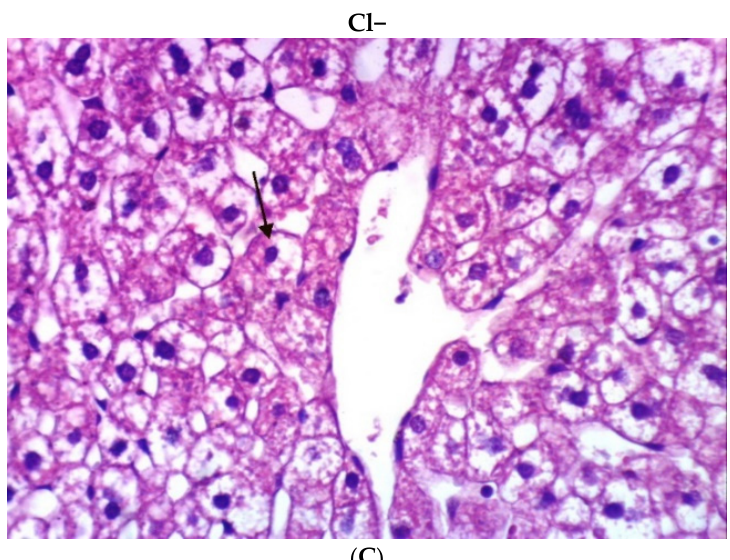
Figure 2. ( A ). Villus morphology and morphometry characteristics of the small intestine in the rabbits receiving yogurt fortified with 1% whey protein concentrate (G1), calcium caseinate (G2) and Spirulina powder (G3) as compared to that of non-supplemented yogurt (positive control: Cl+) or a yogurt-free diet (negative control (Cl − ) (H & E X 100). The groups (G1–G3 and Cl+) received yogurt at a dose of 5 g/kg body weight/day. ( B ). Villus morphology and morphometry characteristics of the kidneys of rabbits receiving yogurt containing 1% whey protein concentrate (G1), calcium caseinate (G2), and Spirulina powder (G3) as compared to the non-supplemented yogurt (positive control: Cl+) or yogurt-free diet (negative control (Cl − ) (H & E X 100). The groups (G1–G3 and Cl+) received yogurt at a dose of 5 g/kg body weight/day. ( C ). Villus morphology and morphometry examinations of the liver in rabbits receiving yogurt containing 1% whey protein concentrate (G1), calcium caseinate (G2) and Spirulina powder (G3) as compared the non-supplemented yogurt as a positive control (Cl+) or yogurt-free diet as a negative control (Cl − ) (H & E X 100). The groups (G1–G3 and Cl+) received yogurt at a dose of 5 g/kg body weight/day.